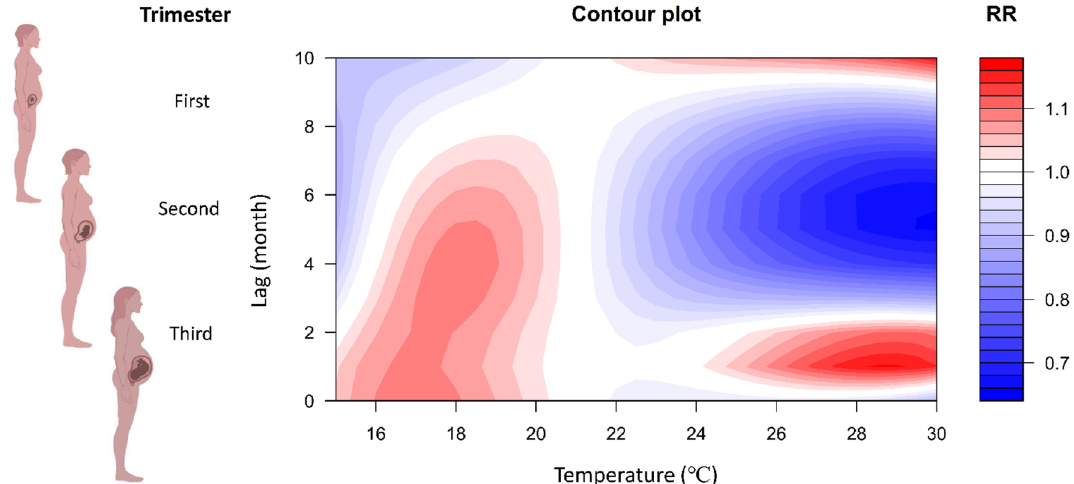
Figure 3. Contour plots of the thermal effect of time lags and temperature on the RR of stillbirth, with the reference of 21 °C. Taiwan, 2009–2018. This figure shows that exposure to both hot and cold temperatures increases the risk of stillbirth in pregnant women in the second and third trimesters. The figures of pregnant women were created with BioRender.com.